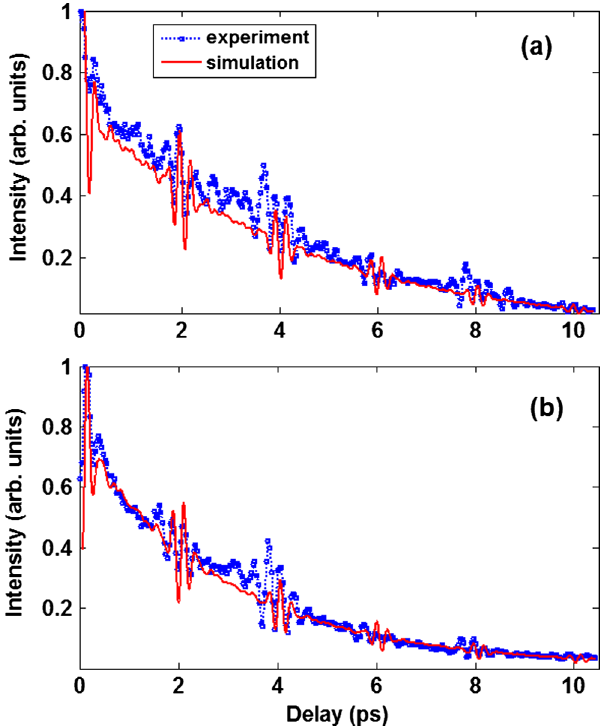
FIG. 4. The experimental (blue dotted lines) and fitted (red solid lines) curves of the signal modulations as a function of the time delay for the parallel (a) and perpendicular (b) cases. Both figures are normalized for